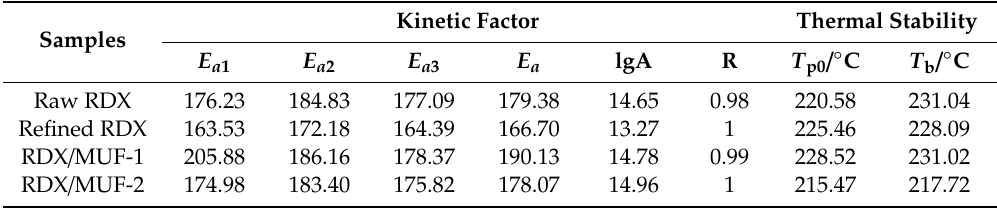
Table 2. Thermal decomposition kinetic parameters of di ff erent RDX